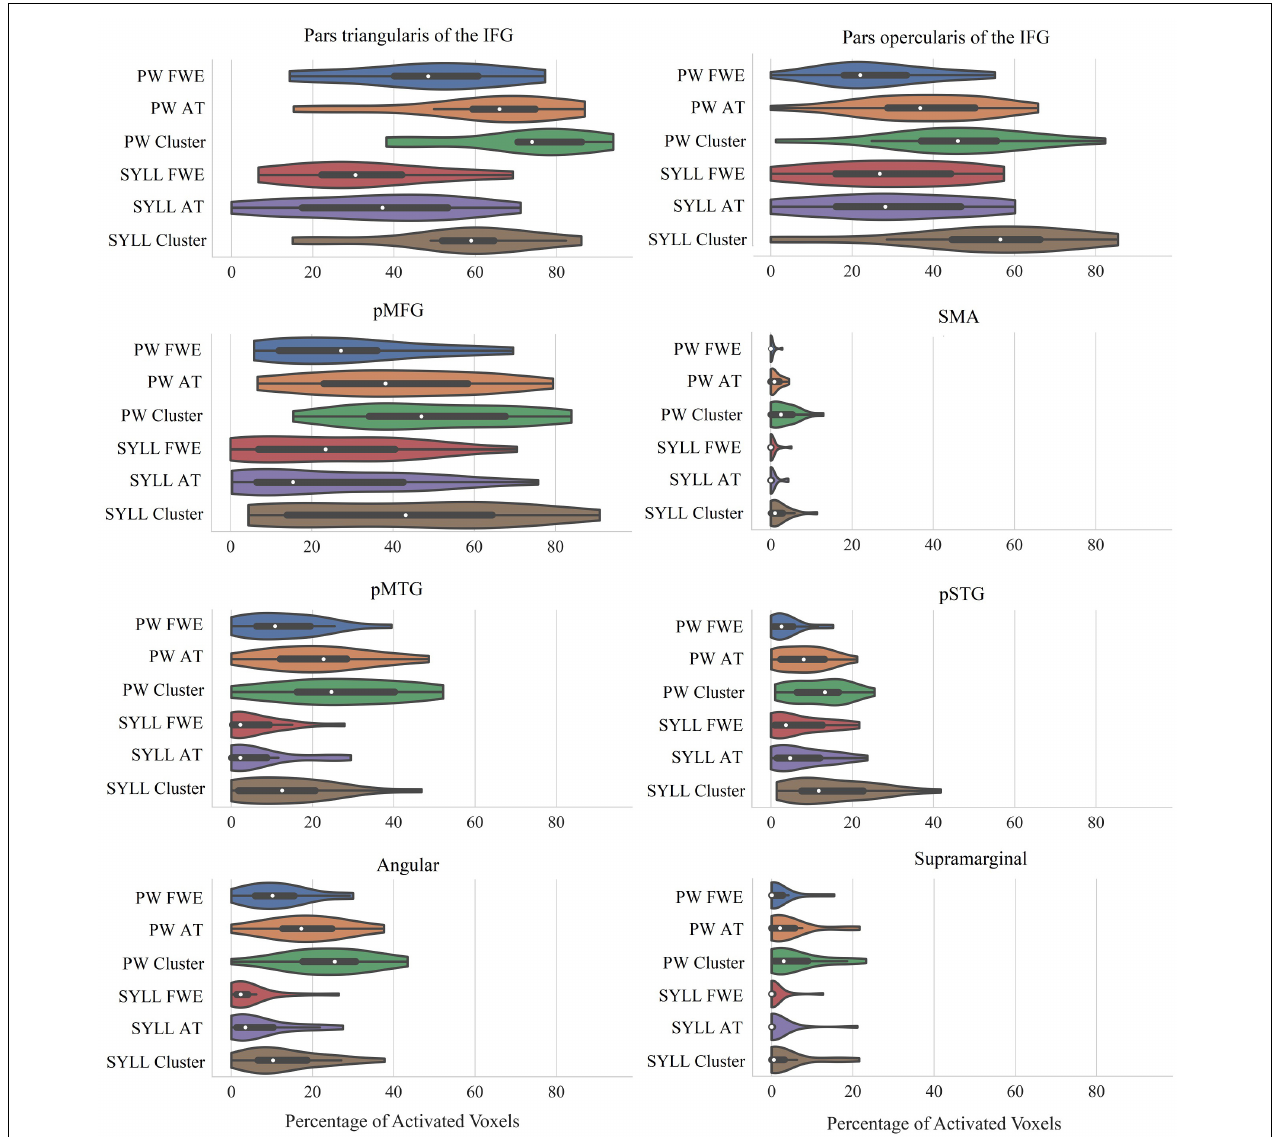
FIGURE 4 | Percentage of significantly activated voxels in language-related ROIs depending on the paradigm (PW, pseudoword baseline; SYLL, syllable baseline) and threshold [FWE: FWE correction for multiple comparisons at α = 0.05; AT: adaptive thresholding as implemented in Gorgolewski et al. (2012) at α = 0.05; Cluster: cluster correction at voxel-wise α = 0.001 and cluster-wise α = 0.05 FWE-corrected]. The white dot in the middle of each “violin” represents the median value and the thick black bar in the center represents the interquartile range. IFG, inferior frontal gyrus; pMFG, posterior middle frontal gyrus; SMA, supplementary motor area; pMTG, posterior middle temporal gyrus; pSTG, posterior superior temporal gyrus; Angular, angular gyrus; Supramarginal, supramarginal